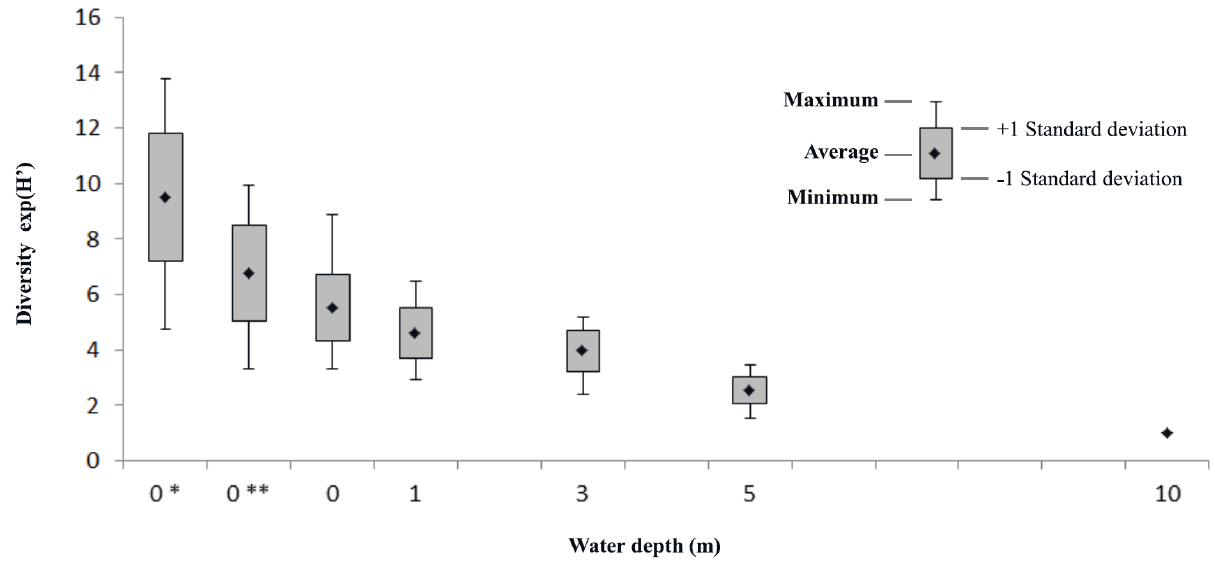
Figure 8. Estimates of biodiversity calculated using the exponential of Shannon entropy, exp( H ′ ), illustrating influence of increasing spectral similarity amongst reef species as a function of increasing water depth: 0* is biodiversity obtained from photoquadrats, 0** is biodiversity calculated using only those species considered prevalent or sizable enough to significantly influence the remote sensing signal ( i.e. , species included in the spectral measurements for this study area), and 0–10 is biodiversity calculated with consideration for optical similarities amongst species ( i.e. , based on hierarchical clustering of reflectance spectra as influenced by the overlying water